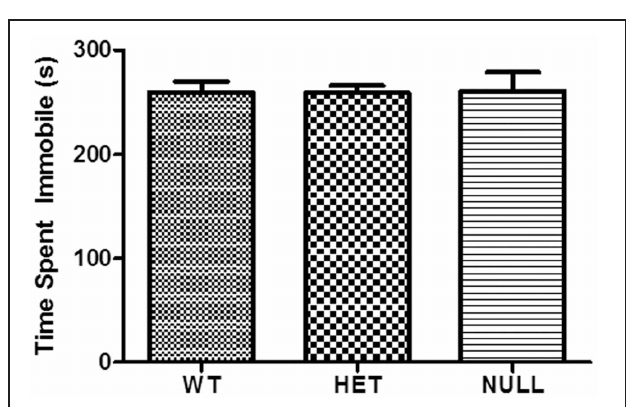
FIGURE 4 | Forced swim test. Forced swim test analysis reveals no significant differences ( p > 0 . 05) between the genotypes in this assay of behavioral despair. Each column represents the average of 4–6